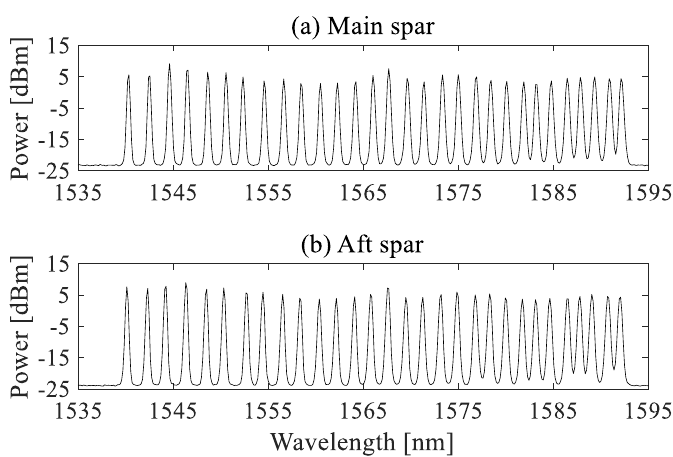
Figure 5. Reflected spectra from optical fiber sensors bonded along the main ( a ) and aft ( b ) spars.